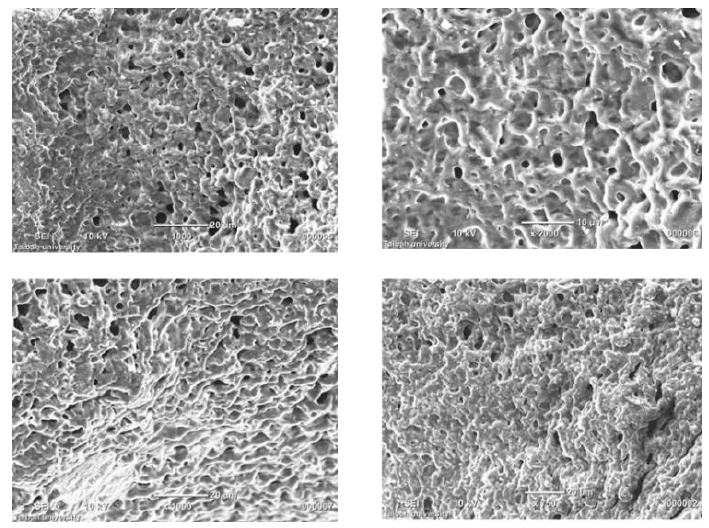
Figure 3. Scanning Electron Microscope (SEM) of polynorbornene containing spiropyran 9 .